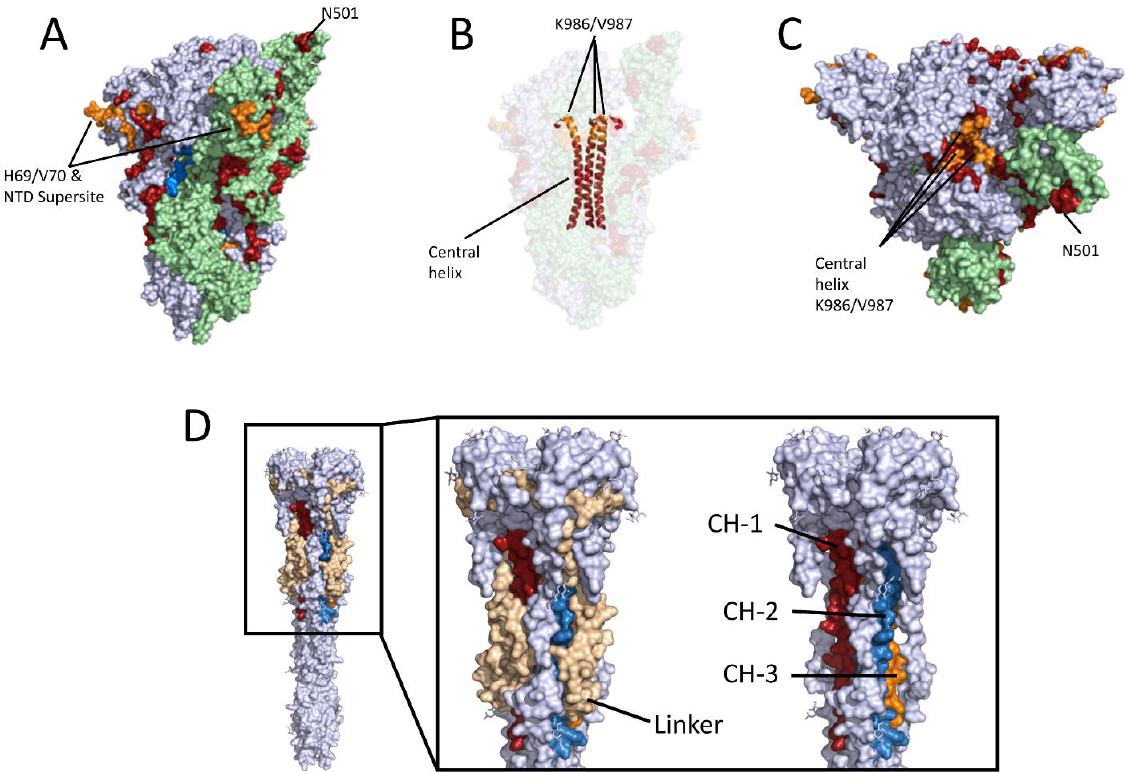
Figure 3. Location of the linear epitopes in the pre-fusion stabilized S protein and post-fusion S protein structure. ( A – C ) Pre-fusion stabilized S Protein (PDB: 6VYB). Gray: pre-fusion dimer in closed-state; green: pre-fusion monomer in open-state (RBD-UP); blue: linear epitopes present only in vaccinated sera; orange: linear epitopes present in both groups; red: linear epitopes exclusive in convalescent sera. ( D ) Post-fusion S protein (PDB: 6M3W) exposed the CH helices of all three monomers. Gray: Post-fusion trimer; red/blue/orange: CH of the three monomers; beige: linker region.